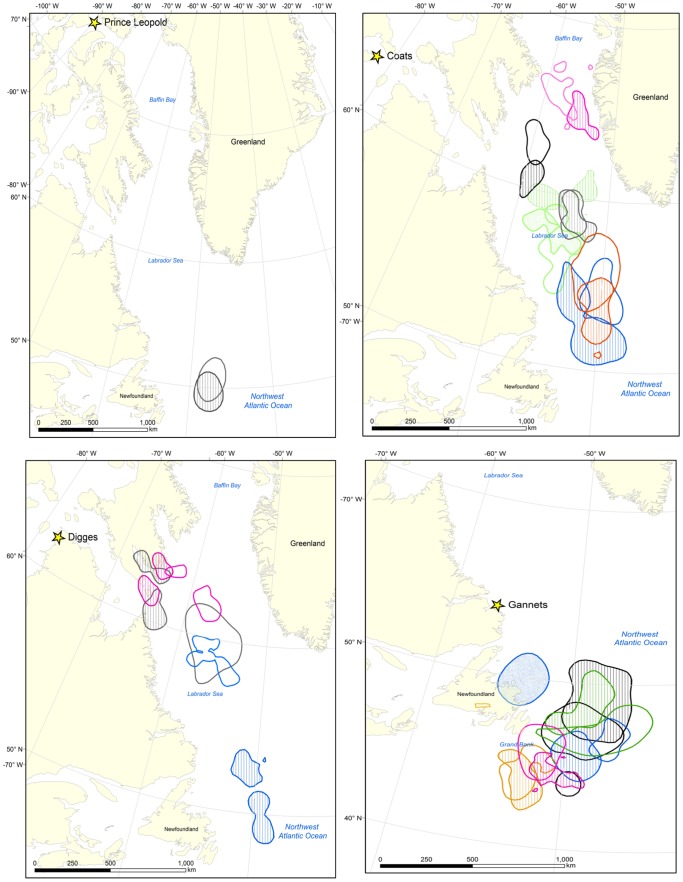
Repeated core winter areas of Thick-billed Murres.Examples of core winter areas (50% KHR) of individual Thick-billed Murres from four colonies (Prince Leopold, Coats, Digges, and Gannet islands), tracked across consecutive years. Colors note repeated observations for the same individual, with cross-hatching to identify the difference between years. To facilitate interpretation in areas of high kernel overlap, only a selection of repeat tracks is shown.